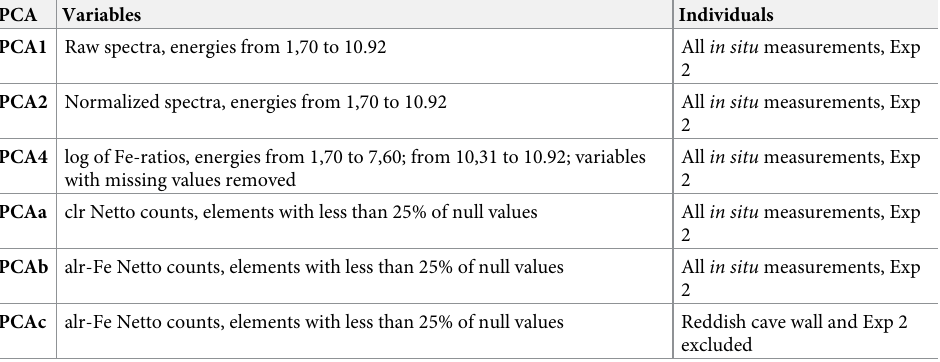
Table 4. Summary of the variables (energies and elements) and individuals (measurements) used in the different PCAs. PCA Variables Individuals PCA1 Raw spectra, energies from 1,70 to